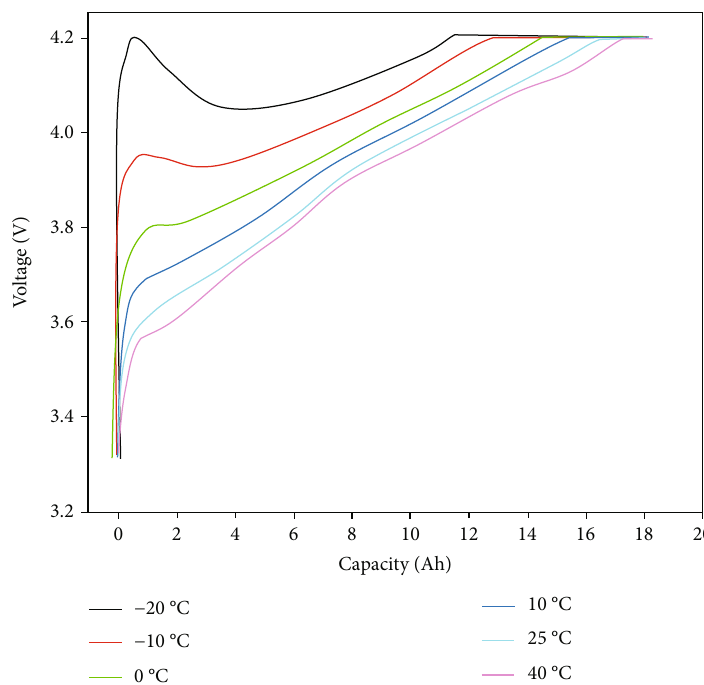
Figure 5: Battery charging capacity-voltage curves at di ff erent temperatures (1C).